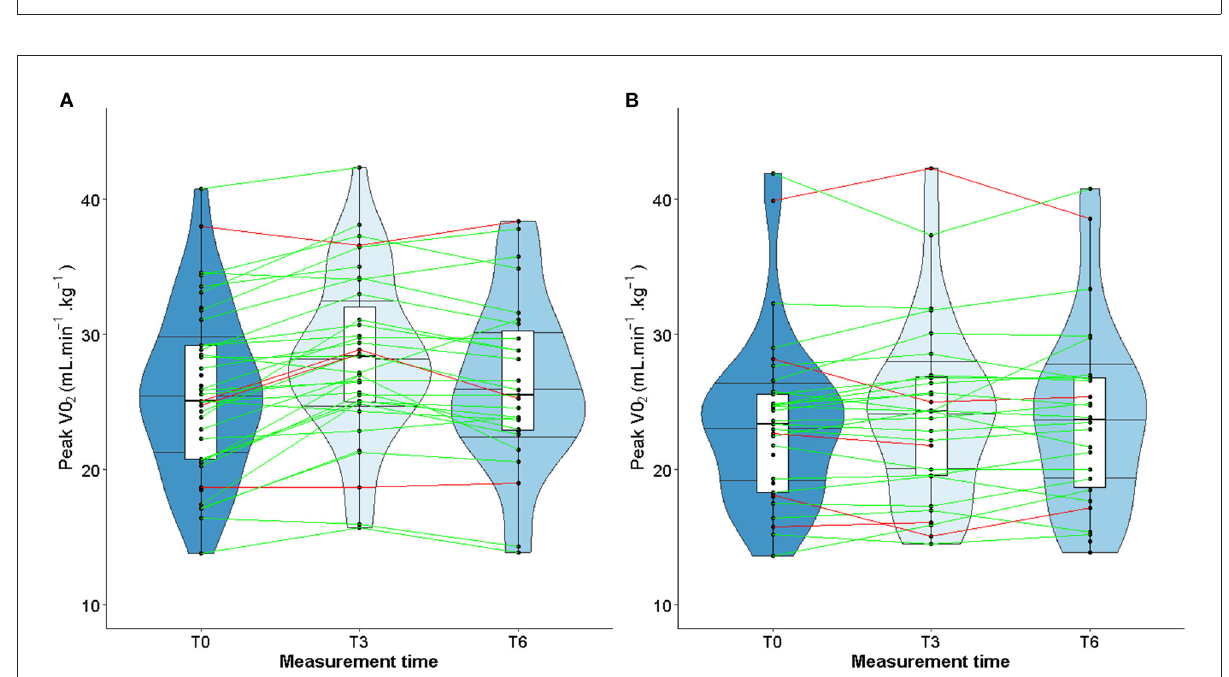
FIGURE4 Violin plot for evolution of maximal power in TG (A) and CG (B)